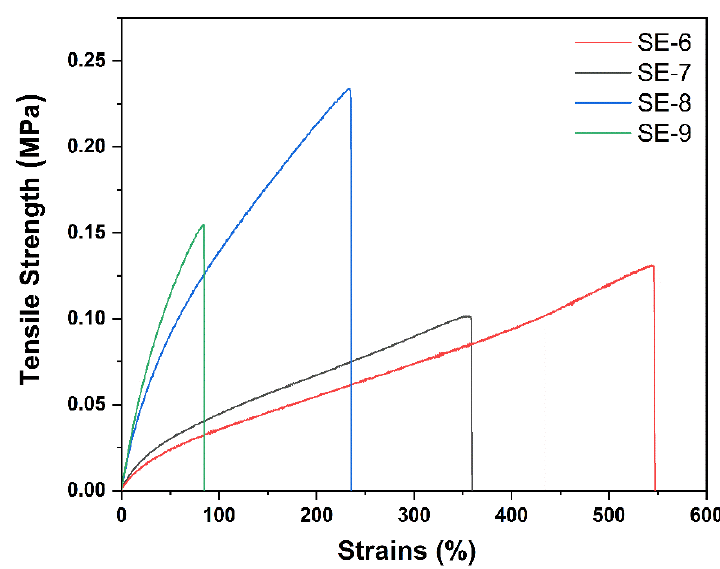
Figure 3. The effect of the cross-linker content on stress of the elastomer.